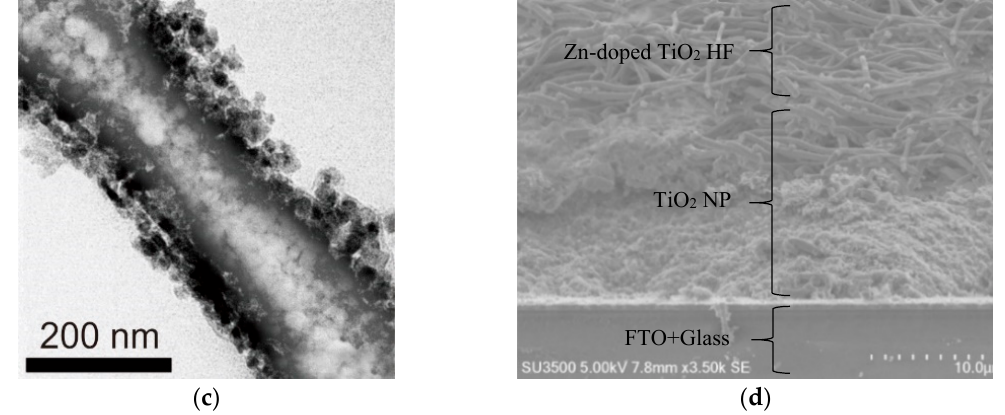
Figure 2. SEM images of ( a ) TiO 2 NP, and ( b ) Zn-doped TiO 2 HF; ( c ) TEM images of Zn-doped TiO 2 HF; ( d ) Cross section images of photoanode double layer that consists of 15 μ m TiO 2 NP and 5 μ m Zn-doped TiO 2 HF layers.